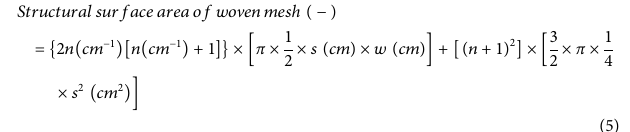
TABLE 5 | Characteristic of Ni expanded mesh.